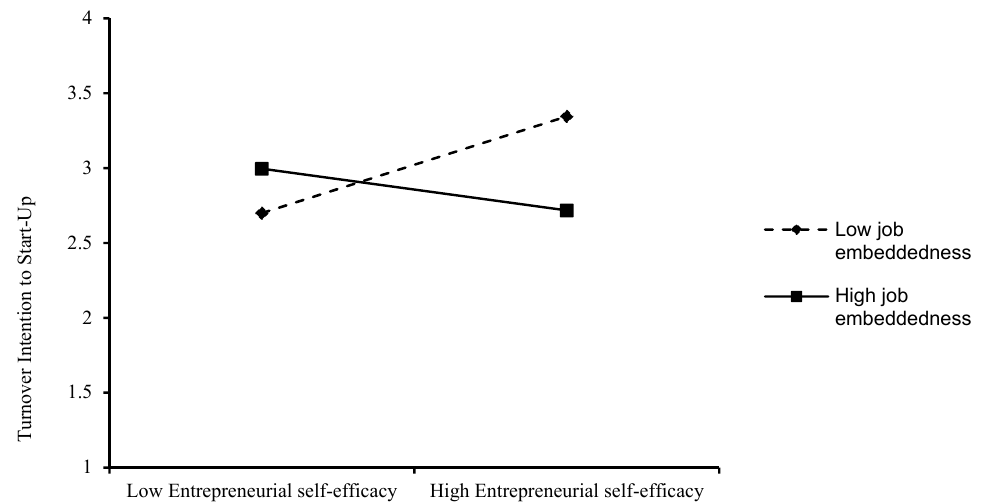
Figure 2. Interactive effects of Entrepreneurial Self-Efficacy and Job Embeddedness on Turnover Intention to Start-Up. Table 4. Table of tests for mediating effects with